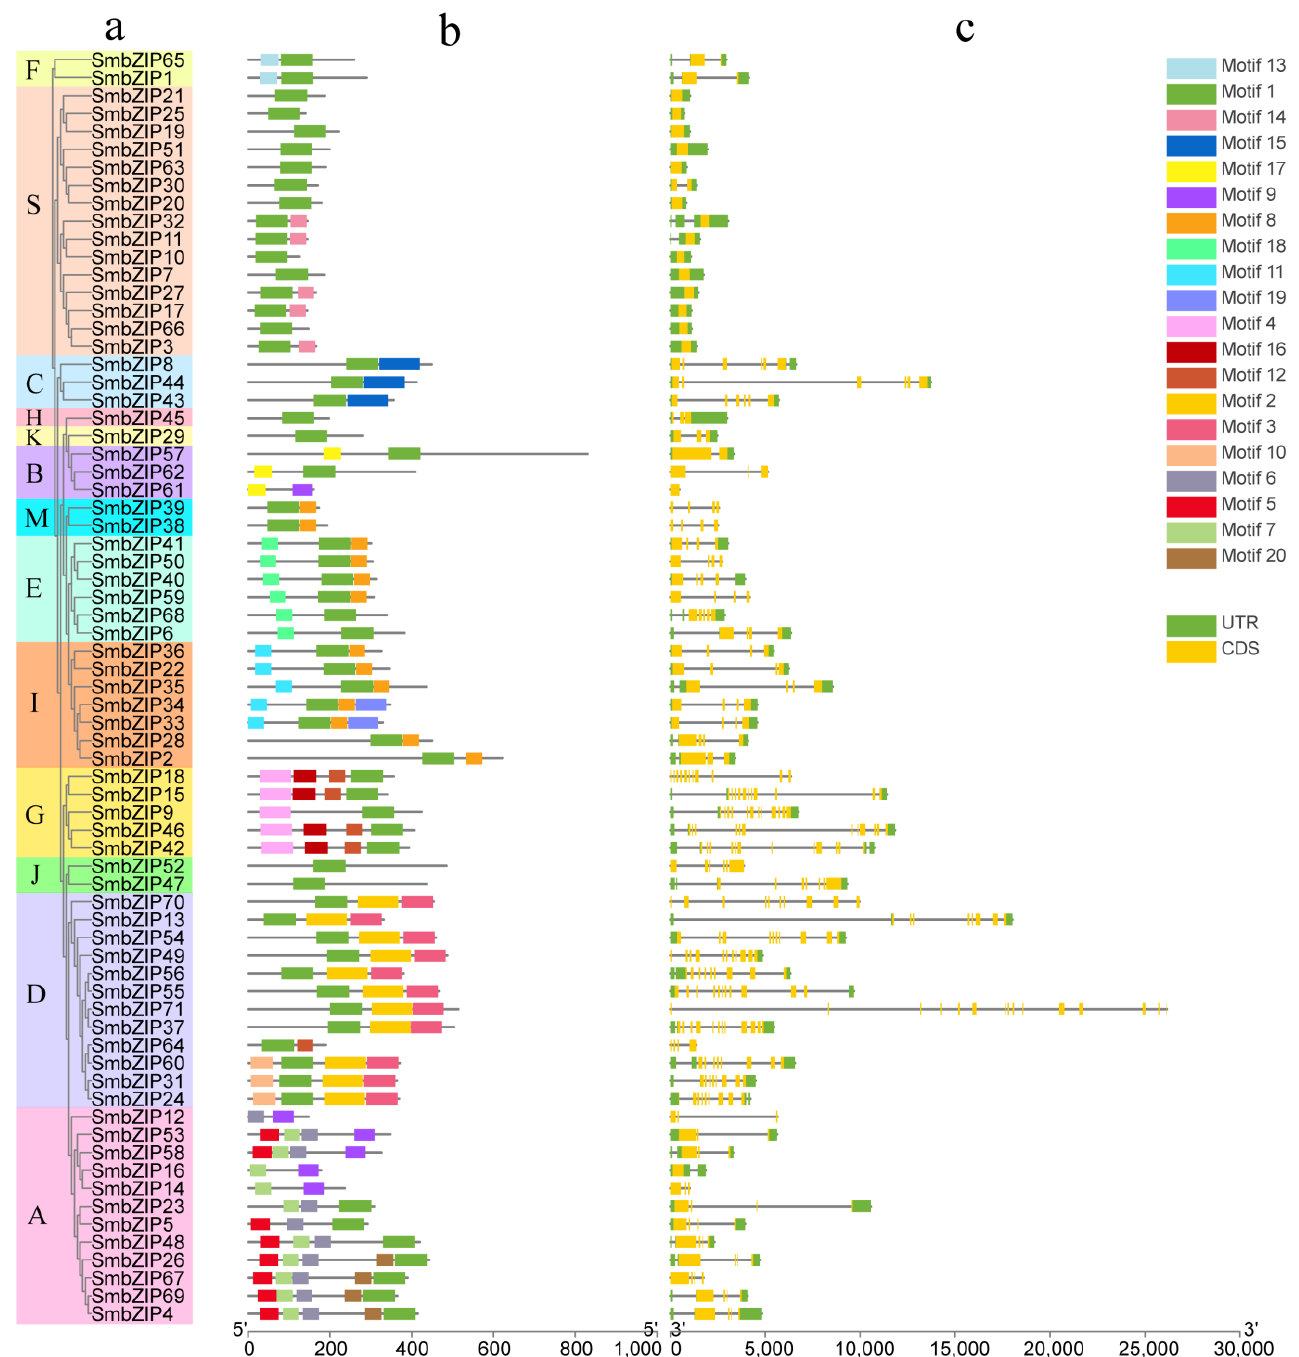
Figure 4. Phylogenetic relationship, conserved motif compositions and gene structure of SmbZIP proteins. ( a ) The maximum-likelihood tree based on the 71 SmbZIP domain sequences with 5000 boot- strap replicates. ( b ) The conserved motifs in the SmbZIP proteins were detected by MEME analysis and represented by color boxes. ( c ) The gene structure of SmbZIPs were analyzed by TBtools. Introns and exons are represented by black lines and orange round-cornered rectangles, respec- tively.